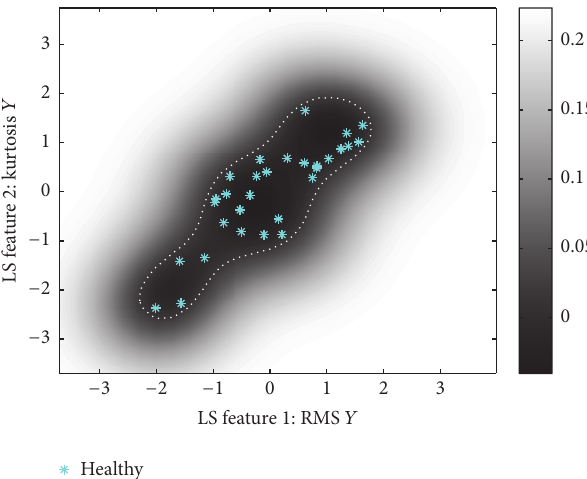
Figure 5: Initial novelty model representation. Limit of the novelty threshold, ⋅⋅⋅ , and measurements used to train the model, ∗